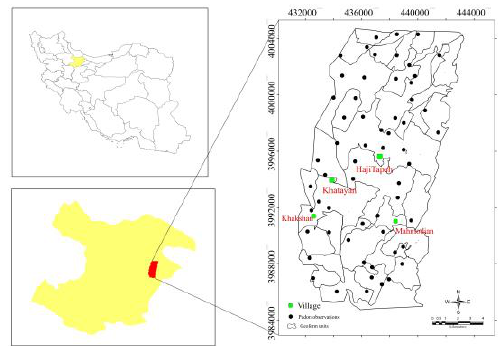
Figure. 1 Location of the study area with Pedon